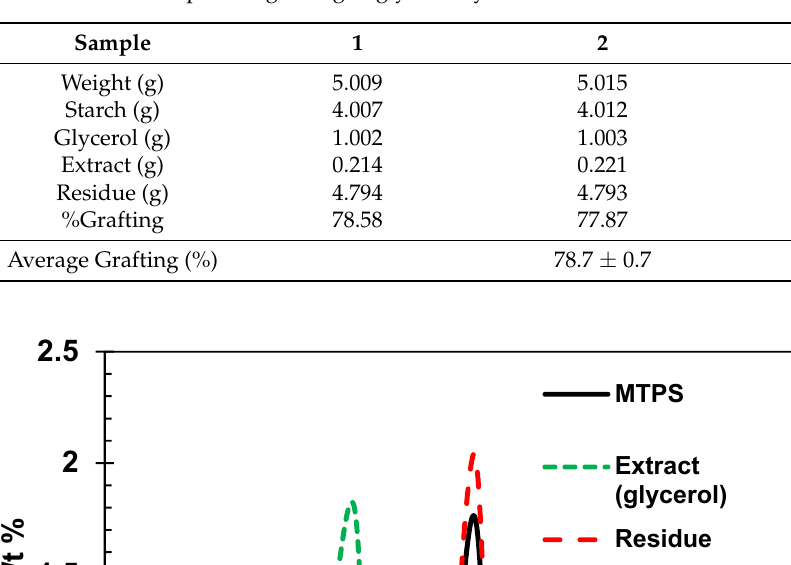
Table 4. Results for percent grafting of glycerol by Soxhlet extraction.